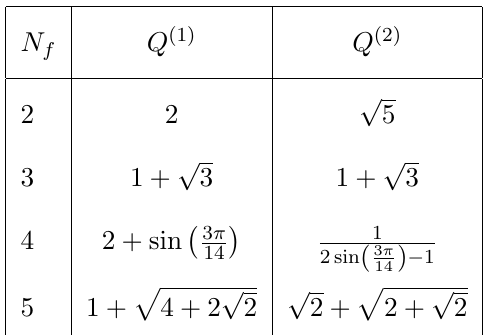
Table 2 . Quantum dimensions of the internal degrees of freedom of [1 ; 0]-solitons ( Q (1) (cid:17) Q (1) and [1 ; 1]-solitons ( Q (2) (cid:17) Q (2) ) derived from (2.16) using the asymptotic solutions of the auxiliary j 0 ; 2 modes (see table